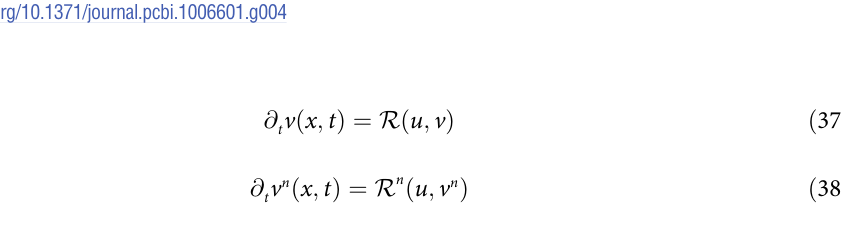
Fig 4. (a) Numerical simulation (time dependent external concentration u ext ( t )) of overall dye incorporation per unit volume for different Biot numbers, u = 1 μM . (b) Moment of inertia M 2 as a function of time, same conditions as in ext (a). (c) Numerical simulation of overall dye incorporation per unit volume for different [dye], u ext = 1 μM . (d) Moment of inertia M 2 as a function of time, same conditions as in